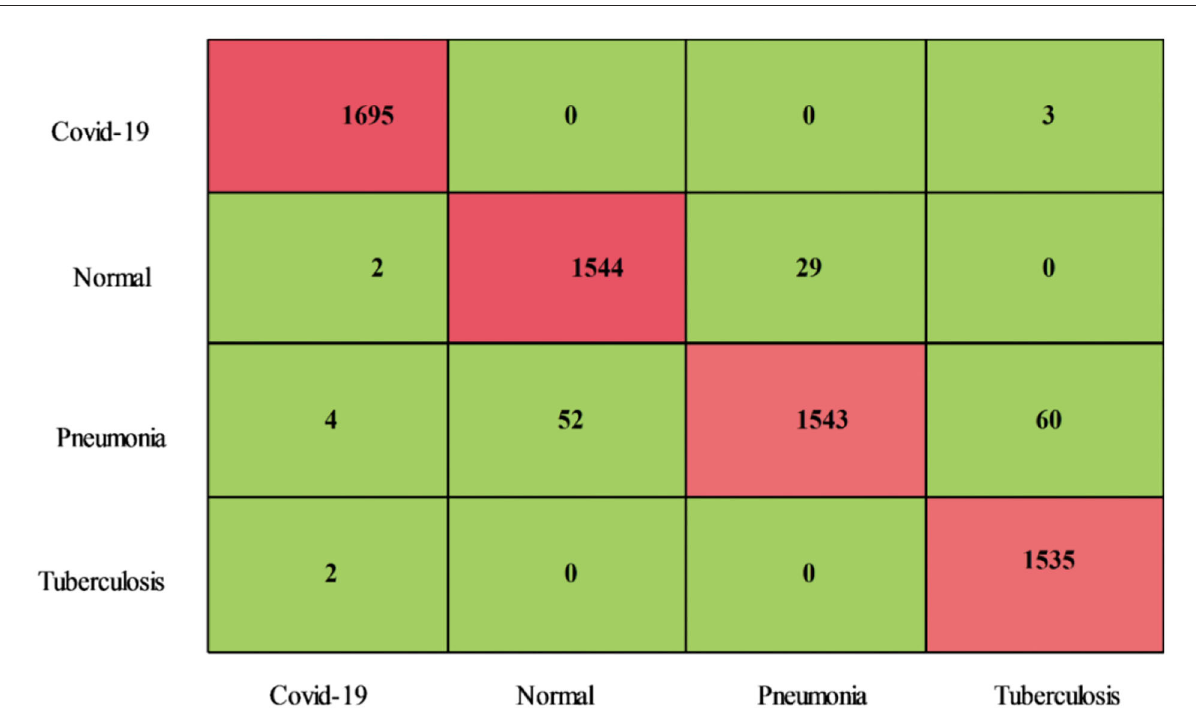
FIGURE14 Confusion matrix of chest X-ray dataset for proposed fusion method.